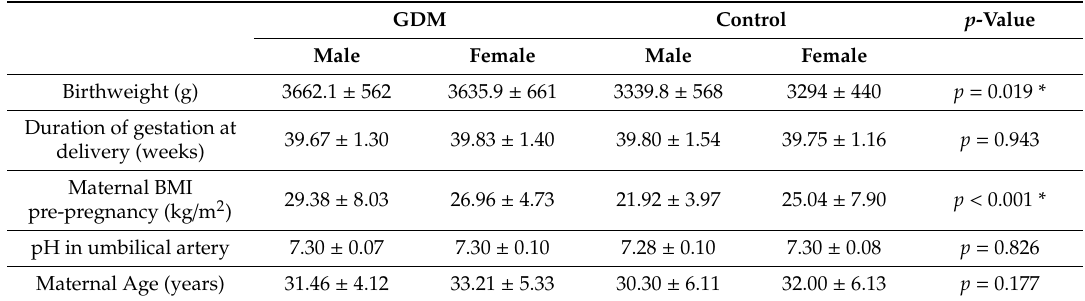
Table 2. Clinical and epidemiological data of study cohort by fetal gender. The data were analysed using the Kruskal Wallis Test.